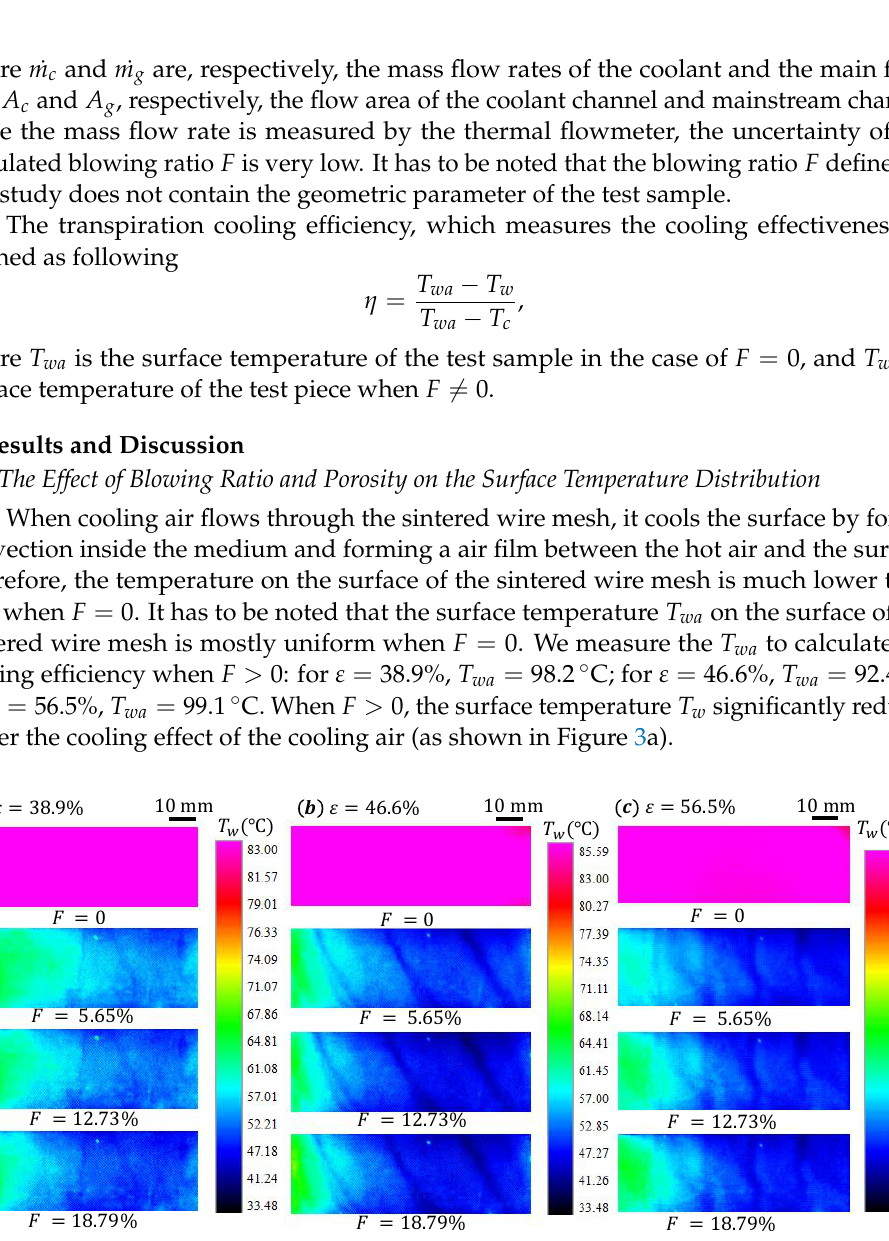
Figure 3. Temperature contour on the surface of the sintered wire mesh for different porosity and blowing ratios. The heated mainstream air flows from left to right, which is denoted as the x -axis. The legends are adjusted to show the distribution of the temperature on the surface when F (cid:54) =